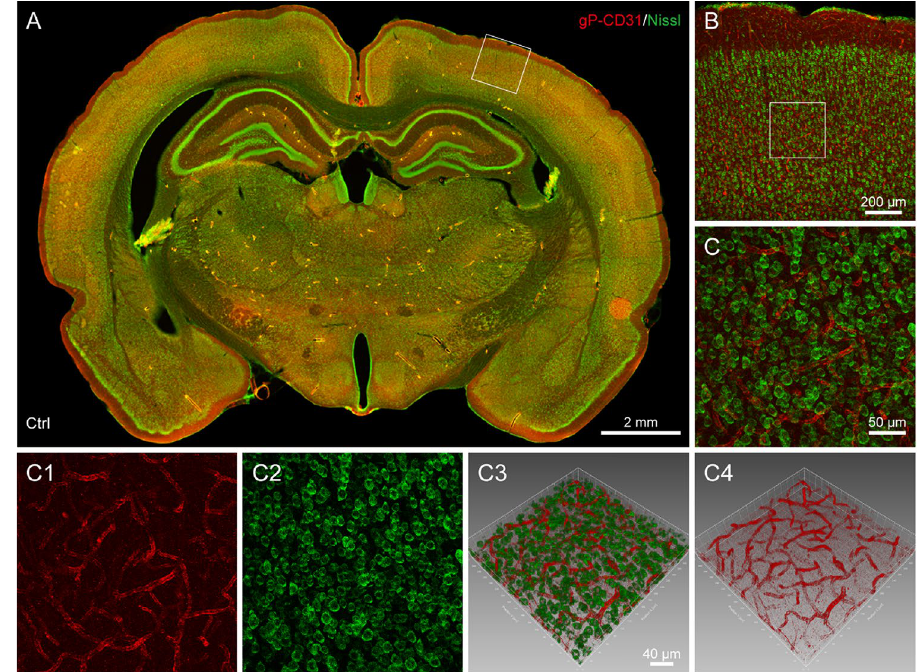
Figure 1. Distribution of vascular and cellular labeling with goat polyclonal anti-CD31 (gP-CD31) and Nissl in the healthy rat brain. ( A ) Representative montage view from the coronal section of healthy brain immunofluorescently labeled with gP-CD31 and Nissl. ( B ) Magnified photograph from panel A (box-indicated region) showing the distribution of vascular and cellular labeling in the cerebral cortex. ( C – C4 ) The higher magnified photographs from the panel B (box-indicated region) showing the detailed vascular and cellular labeling ( C ) separately with gP-CD31 ( C1 ) and Nissl ( C2 ), and further adjusted in a sloping pattern with three- dimensional reconstruction ( C3 , C4 ). Scale bars: 2 mm in ( A ), 200 μm in ( B ), 50 μm in ( C – C2 ), and 40 μm in ( C3 – C4 ).